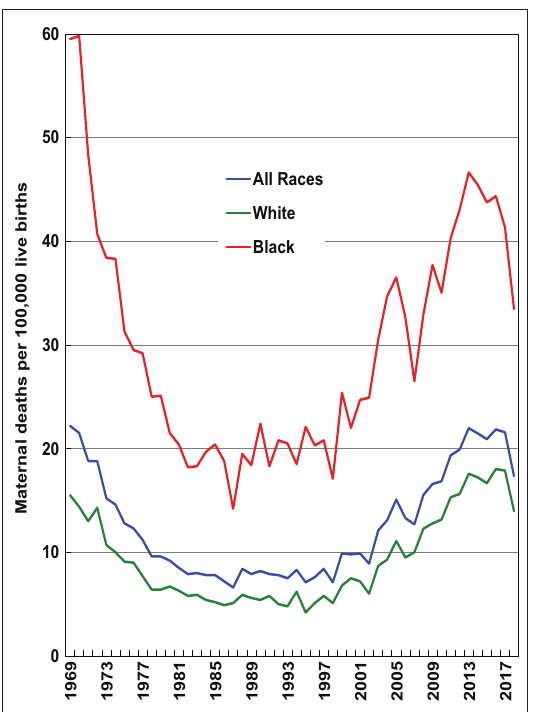
Figure 1 : Trends in Maternal Mortality by Race, United States, 1969-2018. Source: Data derived from the National Vital Statis- tics